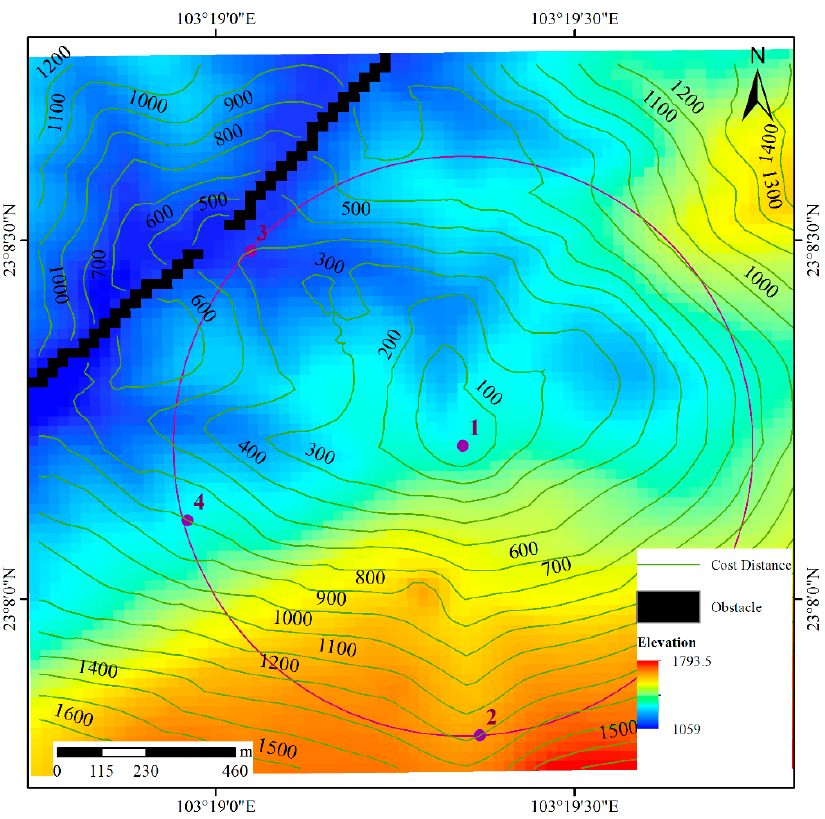
Figure 7. Cost distance to original point 1 in raster space.